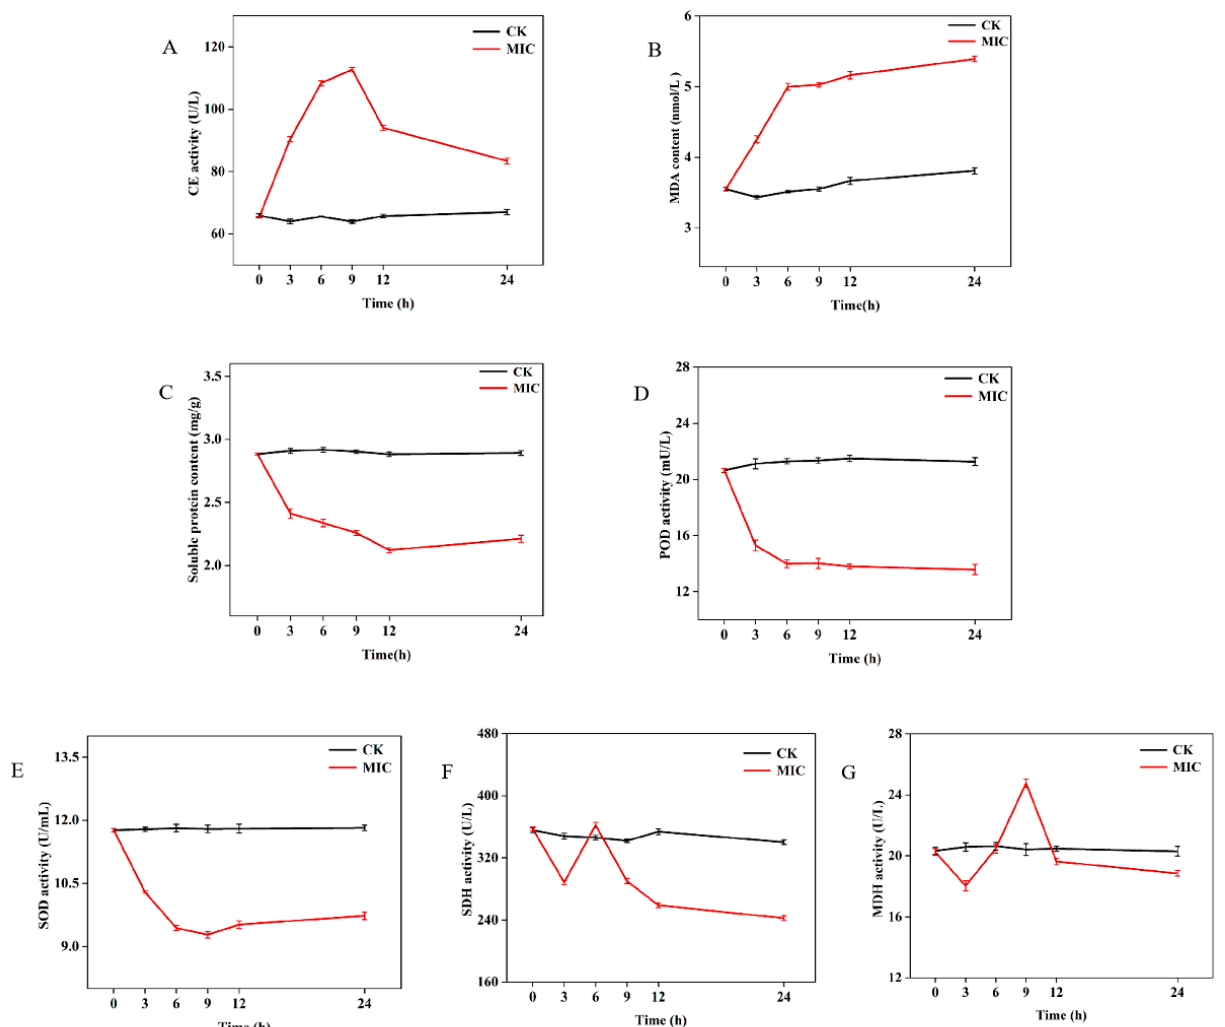
Figure 5. Effects of geraniol on related enzymes activity and content of C. camelliae ; ( A ) effects of geraniol on CE activity; ( B ) effects of geraniol on MDA content; ( C ) effects of geraniol on soluble protein content; ( D ) effects of geraniol on POD activity; ( E ) effects of geraniol on SOD activity; ( F ) effects of geraniol on SDH activity; ( G ) effects of geraniol on MDH activity.